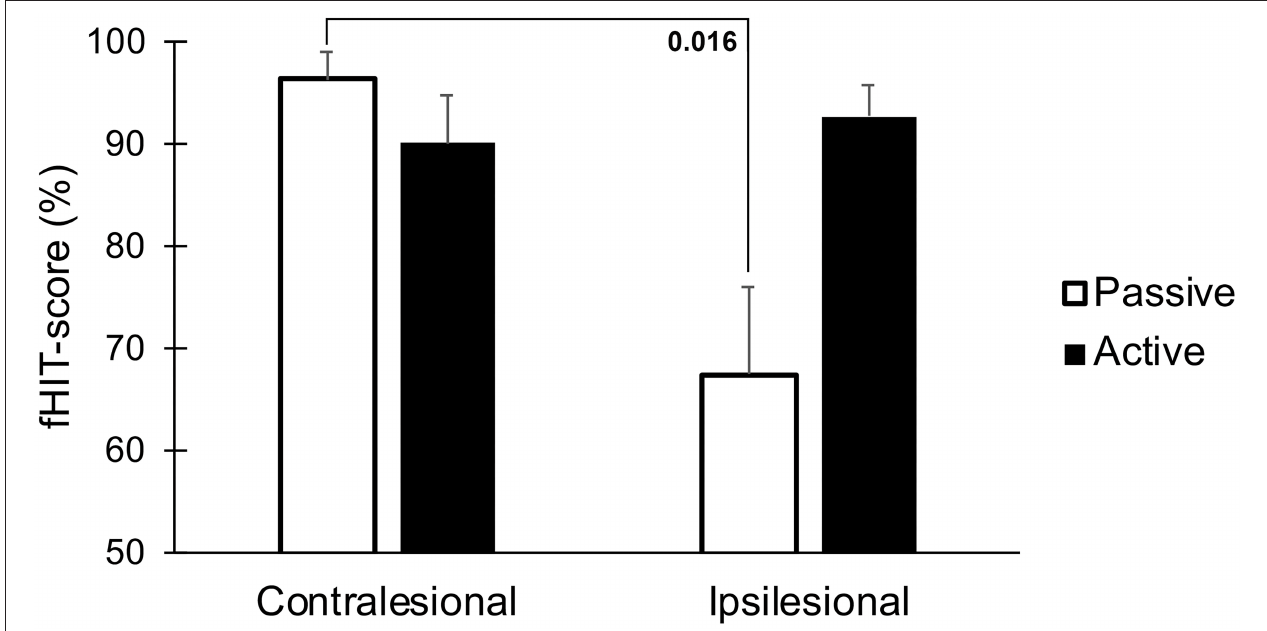
FIGURE 6 | Accuracy of visual perception as assessed by the fHIT test when performing head thrusts in the ipsilesional and contralesional directions with active and passive head movements. Bars representing mean values for the group. Error bars indicate SEM. Bonferroni corrected post- hoc statistics presented numerically.